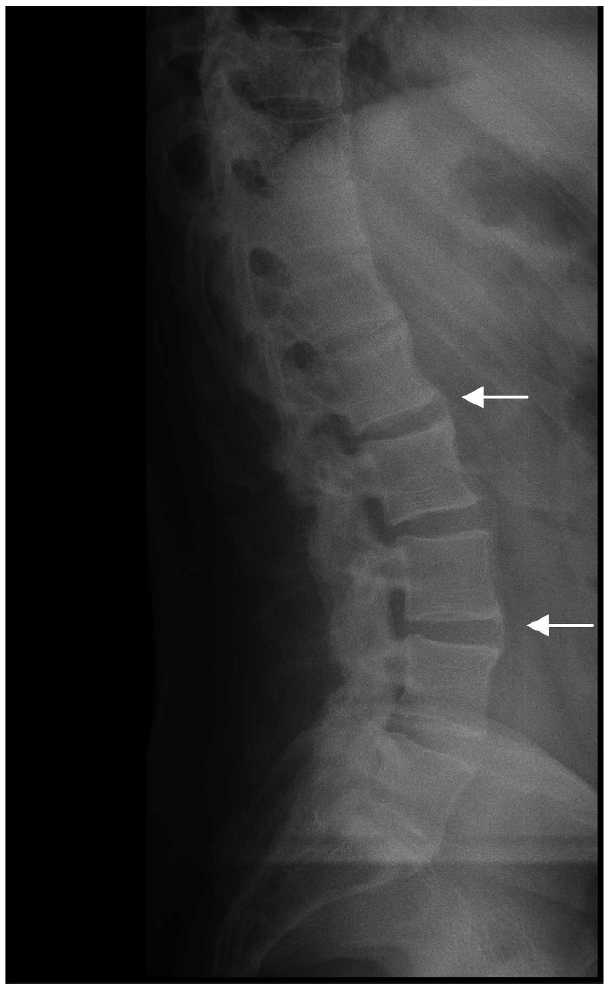
Figure 1 - Lateral radiograph of lumbar spine showing marginal syndesmophytes